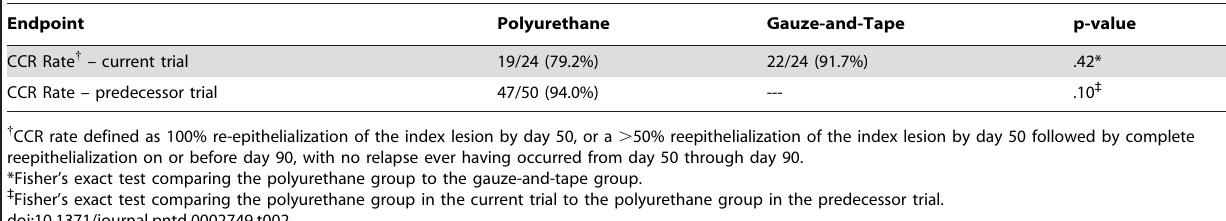
Table 3. Parasite loads in the superficial and deep dermis.